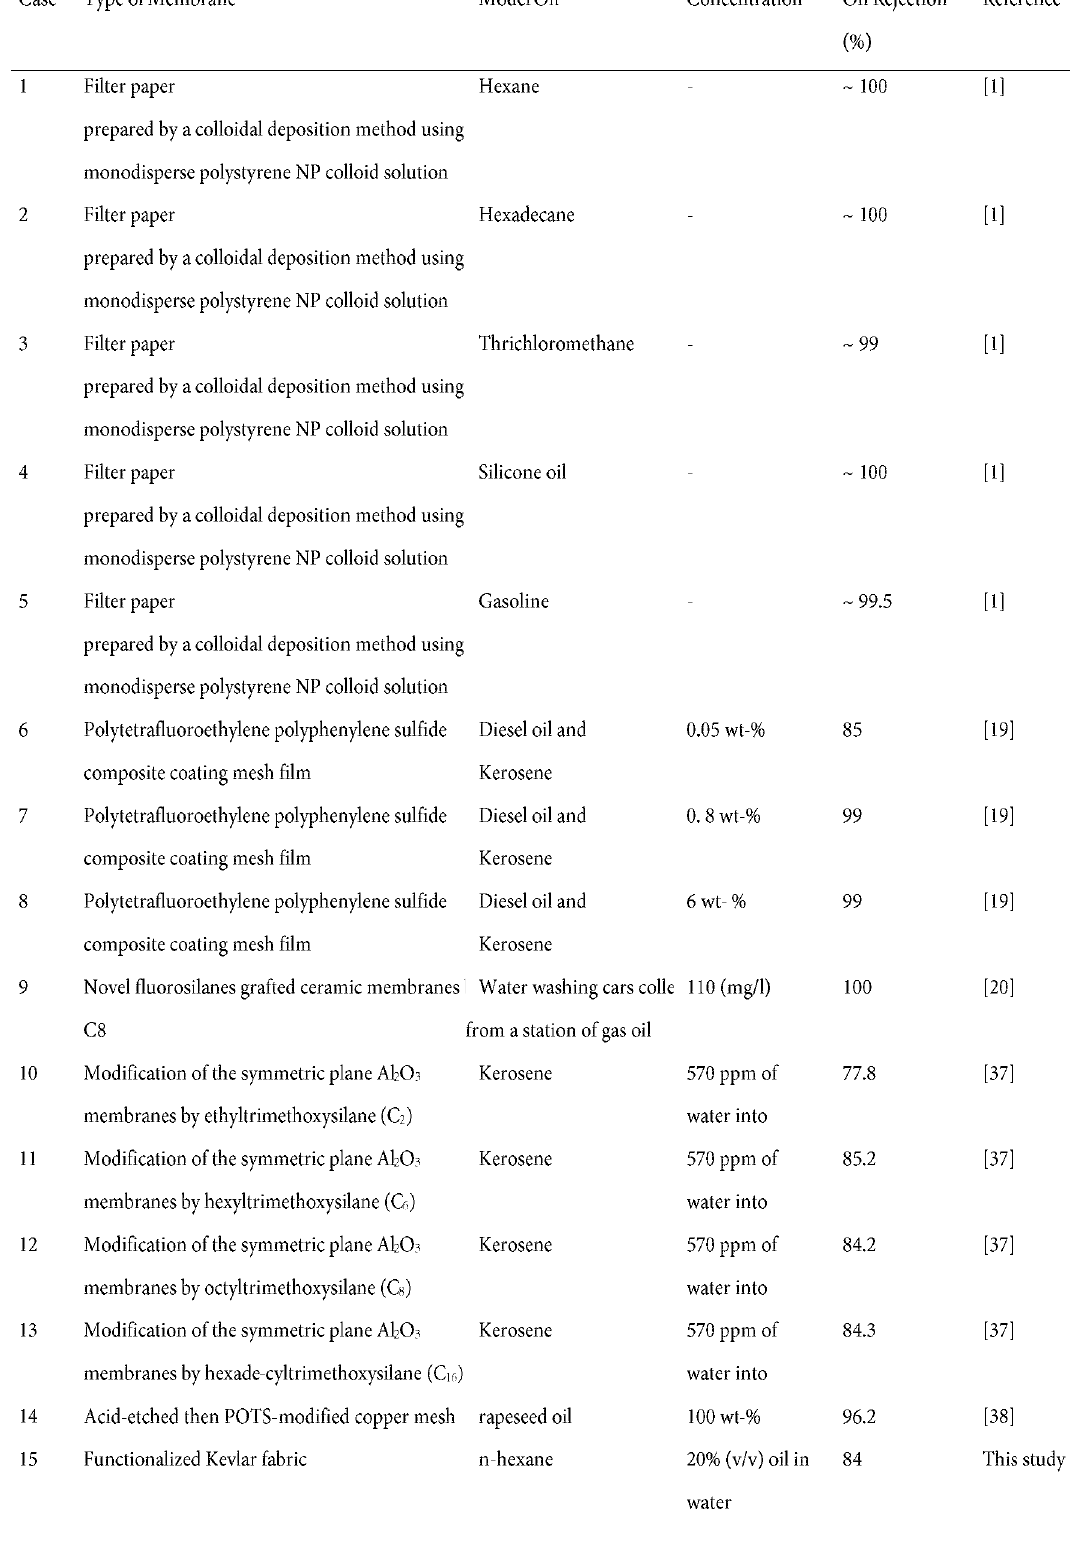
Table 1. Comparison among nanocomposite membranes performance and those reported by other